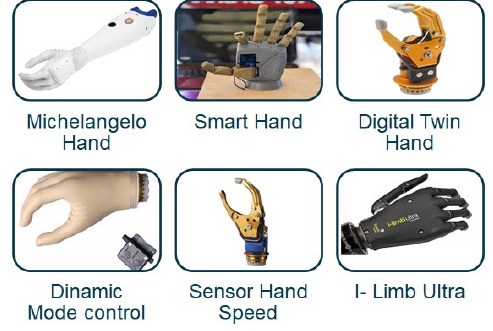
Figure 11. Sample of myoelectric commercial